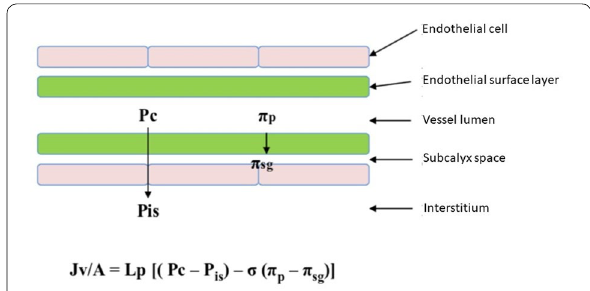
Fig. 3 The revised Starling principle. Reproduced with permission from [2]. Jv/A filtered volume per unit area; Lp hydraulic conductance; Pc capillary hydrostatic pressure; P is interstitial hydrostatic pressure; σ osmotic reflection co-efficient; π p oncotic pressure in the luminal side of endothelial surface layer; π sg oncotic pressure in the subglycocalyx